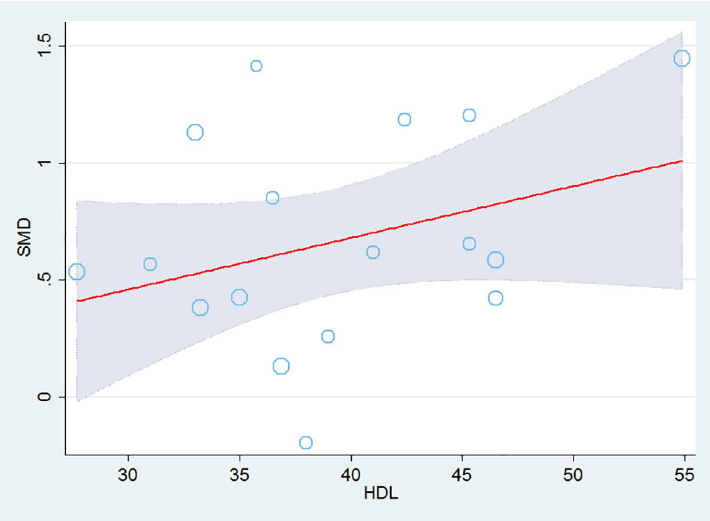
Fig 5. Dose-response relationships between HDL value index and SMD value outcomes based on data from each studies. Each data point overlaps into a circle. The size of the circle corresponds to the inverse variance weight of the SMD effect in the analysis.MetS, Metabolic syndrome; SMD, standardized mean difference.